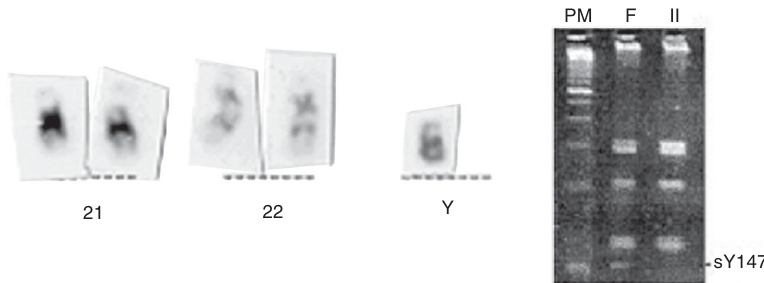
Figure 2. Male infertility studies by classical cytogenetics and multiplex PCR for microdele- tions of AZF gene detection. Partial karyotype of 46,XY,del(Y). Multiplex PCR revealed deletion of one sequence-tagged site (sY147). PM = ladder; F = fertile man; II = mix II showing the sY147